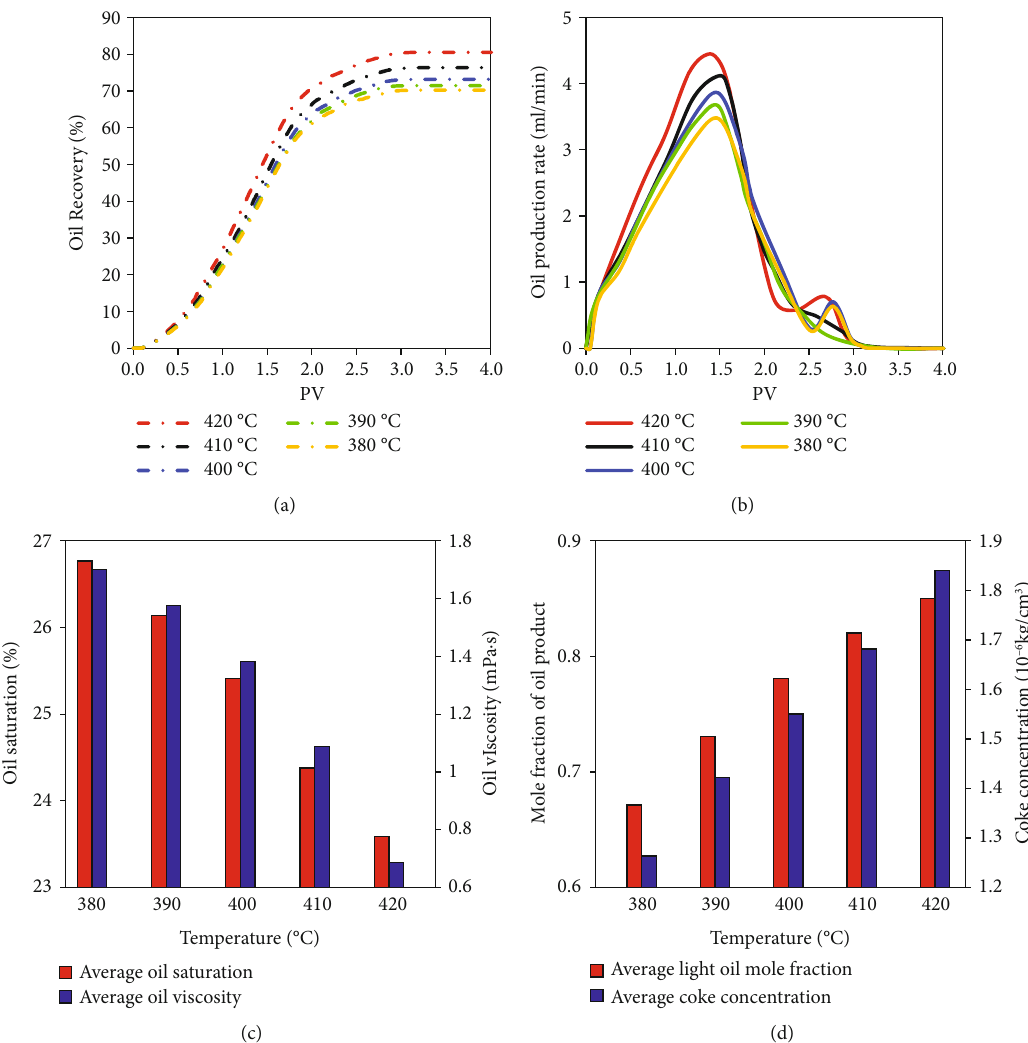
Figure 10: Comparison of simulation results of SCW fl ooding at di ff erent temperatures: (a) oil recovery, (b) oil production rate, (c) average oil viscosity and oil saturation, and (d) average light oil mole fraction and coke